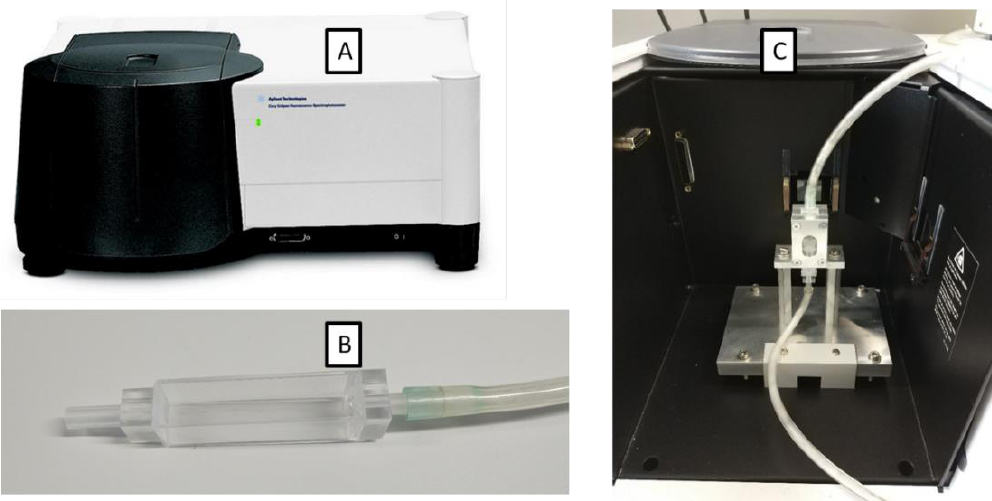
Figure 6. Fluorescence spectroscopy setup: ( A ) fluorescence spectrometer, ( B ) flow through cuvette, and ( C ) special cuvette holder.